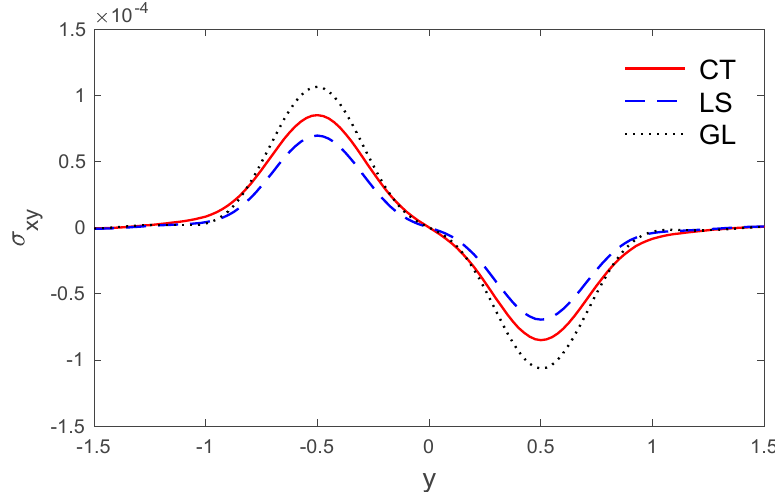
Figure 5. The stress variations σ xy via y , with x = 0.5 under the three models.